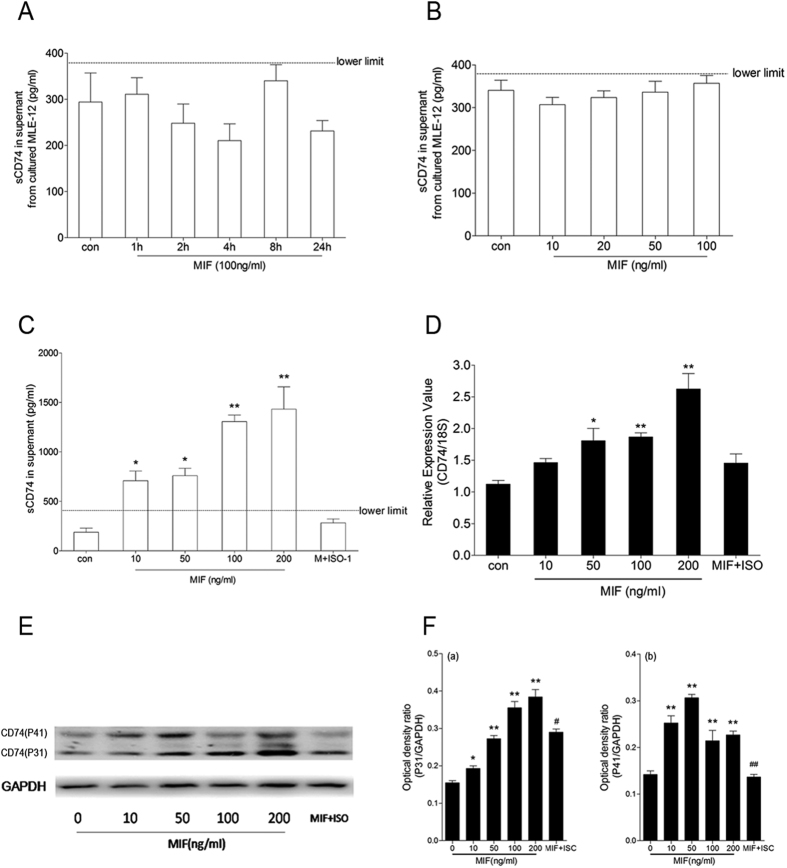
Identification of sCD74 in supernatants of culture cells following stimulation with MIF.(A) MLE-12 cells were treated with 100 ng/ml MIF or control media for different times (1, 2, 4, 8, 24 hrs). Then supernatants were collected and sCD74 concentrations were measured by ELISA. (B) MLE-12 cells were treated with different concentrations of MIF (10, 50, 100, 200 ng/ml) or control media for 24 hrs. (C) RAW264.7 cells were treated with different concentrations of MIF (10, 50, 100, 200 ng/ml) or control media for 24 hrs. In experiment of ISO-1 treatment, RAW264.7 cells were pre-treated with 100 μg/ml ISO-1 for 30 min, following stimulated with 100 ng/ml MIF for 24 hrs. After stimulation, supernatants were collected and subjected to ELISA assay for sCD74. After 24 hrs supernatants were collected and sCD74 concentrations were measured by ELISA. mRNA (D) and proteins (E) were collected and subjected to quantitative real-time PCR and Western blot assays, respectively. Relative protein levels were quantified by densitometry and expressed as optical density ratio with GAPDH serving as internal standards (F). Bar graphs represent the mean ± SEM of three independent experiments. *P < 0.05 and **P < 0.01 compared to control with Dunnett-t test after ANOVA for multiple comparisons.